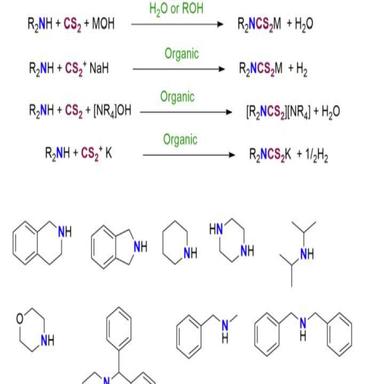
Synthesis of TMDCs from secondary amines, carbon disulphide and base or metal.